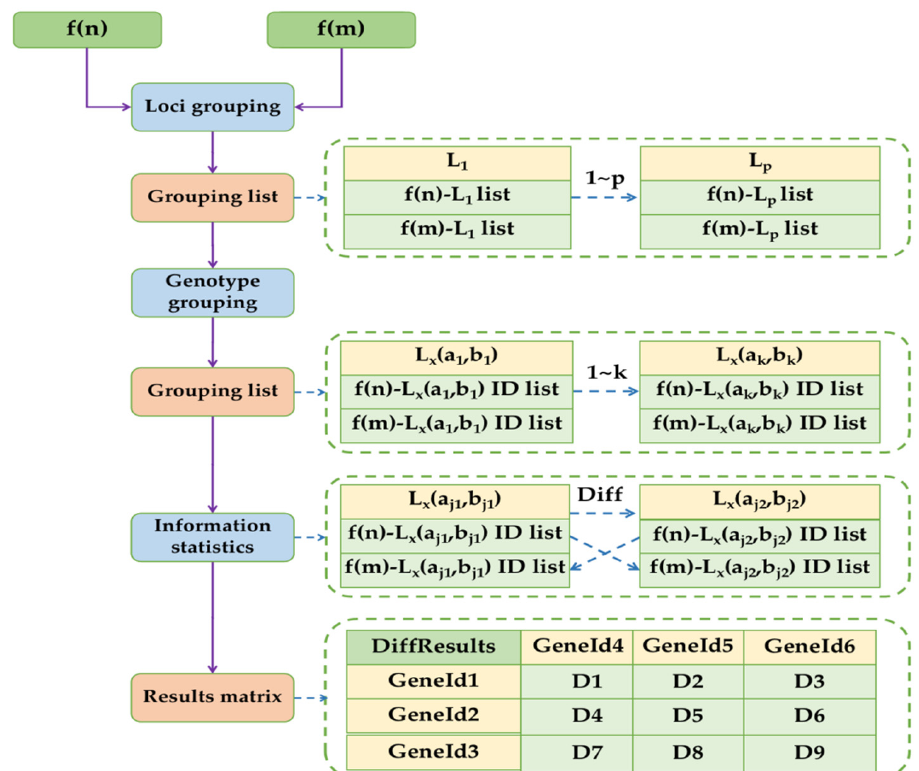
Figure 1. Workflow of the FCGS algorithm. L1-Lp represents the 𝑝 loci data of fingerprint. L x (a 1 , b 1 )-L x (a k , b k ) represents 1-K genotyping data of L x locus (x ∈ ( 1,p ) ). L x (a j1 , b j1 ) and L x (a j2 , b j2 ) represent genotypes of the j1 and j2 ( j1 ∈ ) ,j2 ∈ ( 1,k )) selected from k genotyping data of locus L x .